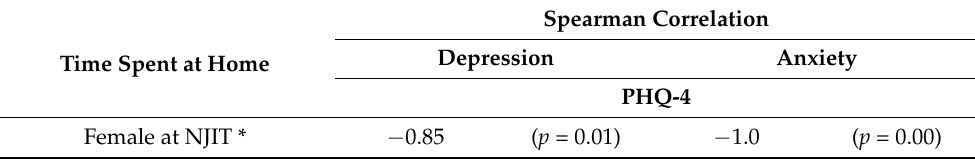
Table 5. Summary statement on the Spearman correlation of time at home measure.